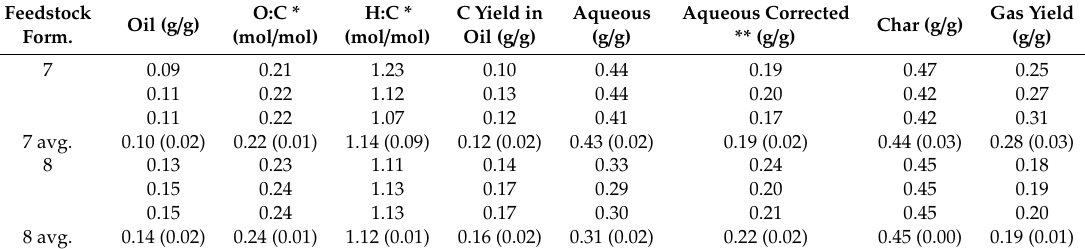
Table 4. Mass yields and CHO data for pyrolysis of magnesium-hydroxide-pretreated lignin. Feedstock